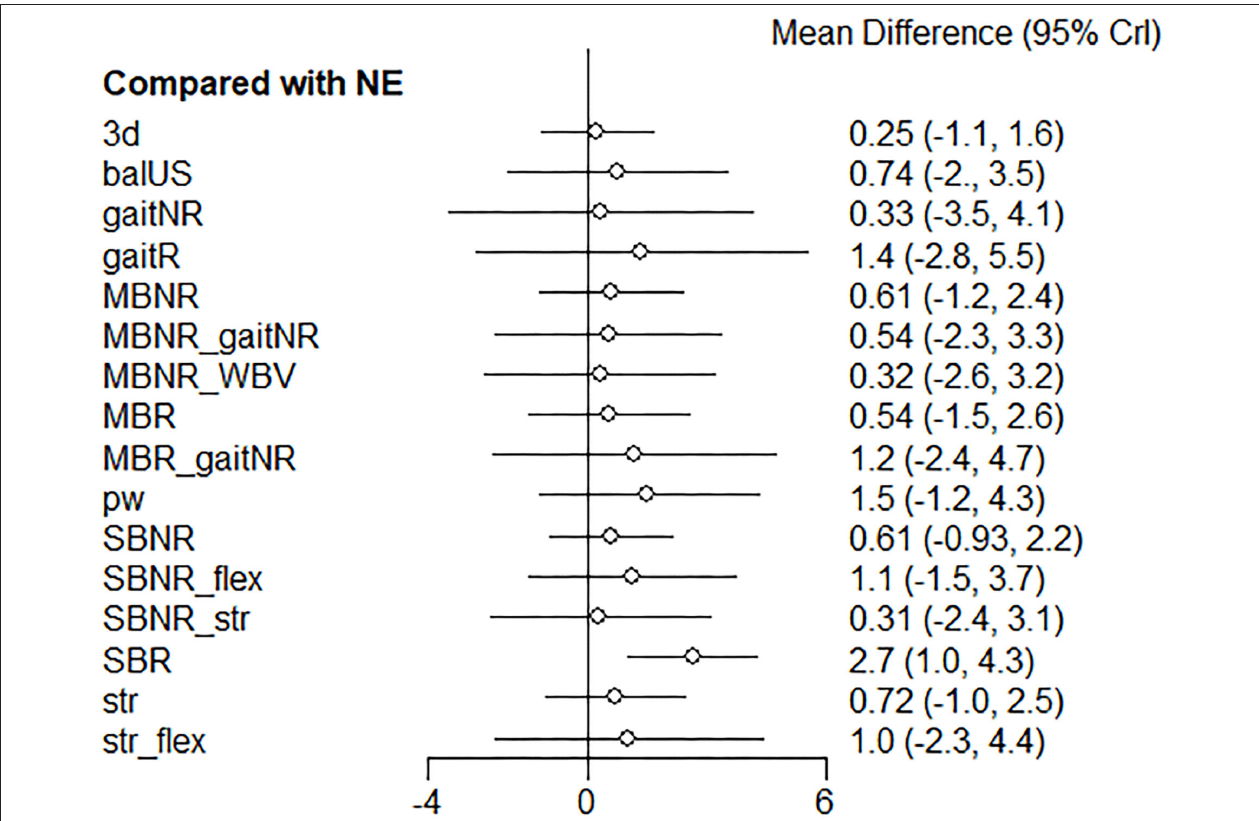
FIGURE 5 | Forest plot of the relative effects of exercise interventions with a no-exercise as a reference group. SBR, Single balance exercise including reactive balance component; SBNR, Single balance exercise not including reactive balance component; MBR, Multiple balance exercises including reactive balance component; MBNR, Multiple balance exercises not including reactive balance component; balUS, Unspecified balance exercise; gaitR, Gait training including reactive balance component; gaitNR, Gait training not including reactive balance component; WBV, Whole body vibration; str, Strength; pw, Power; 3d, 3D exercise; flex, Flexibility; aer, Aerobic; NE, No